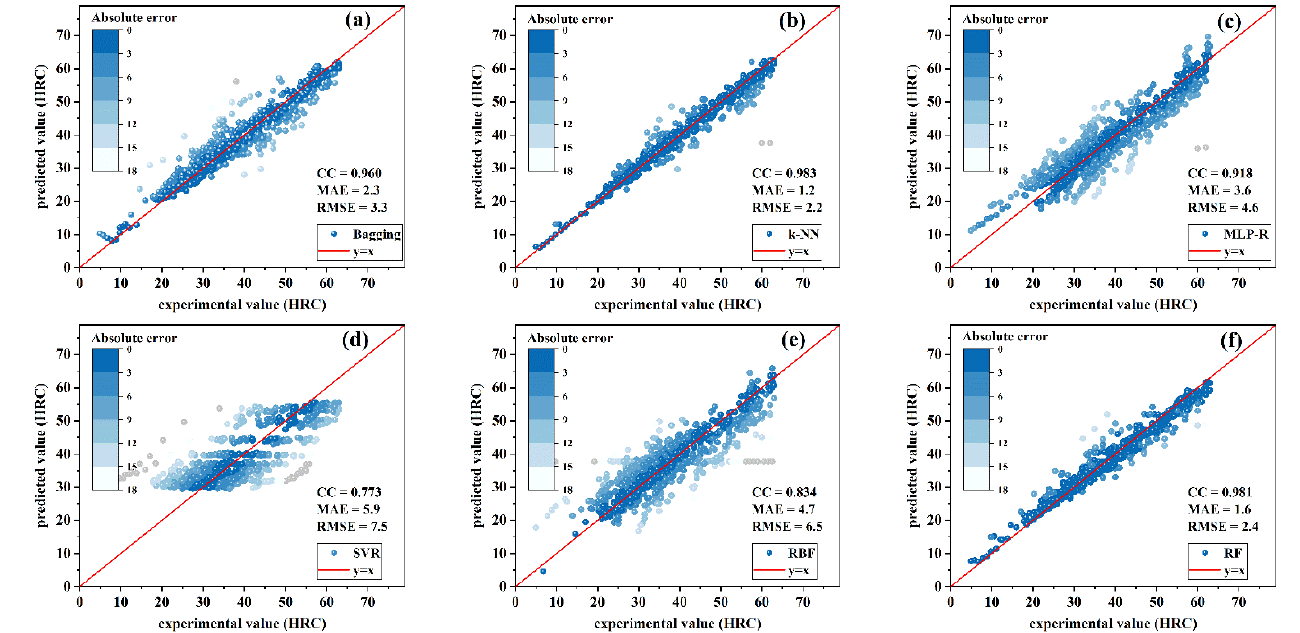
Figure 4. Training results of regression models for low-hardenability steels: ( a ) bagging; ( b ) k-NN;